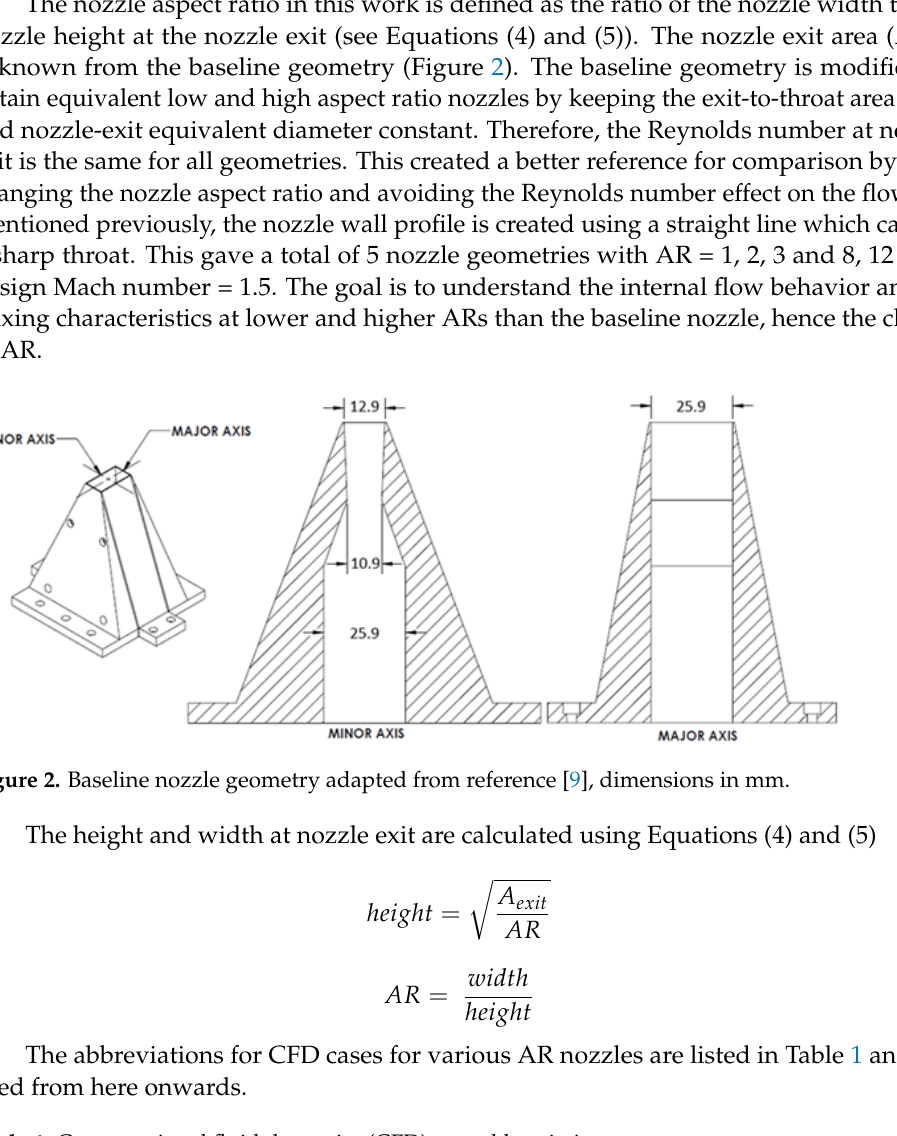
Figure 1 . Mesh and computational domain—( a ) polyhedral mesh on minor and major axis sym- metry planes for the baseline nozzle, ( b ) computational domain.